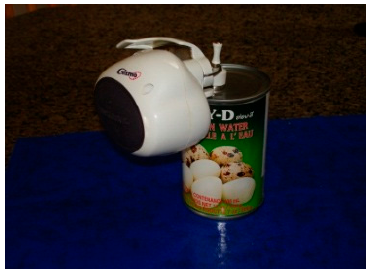
Figure 5. Finding tools for use with only one hand: Battery operated can opener.